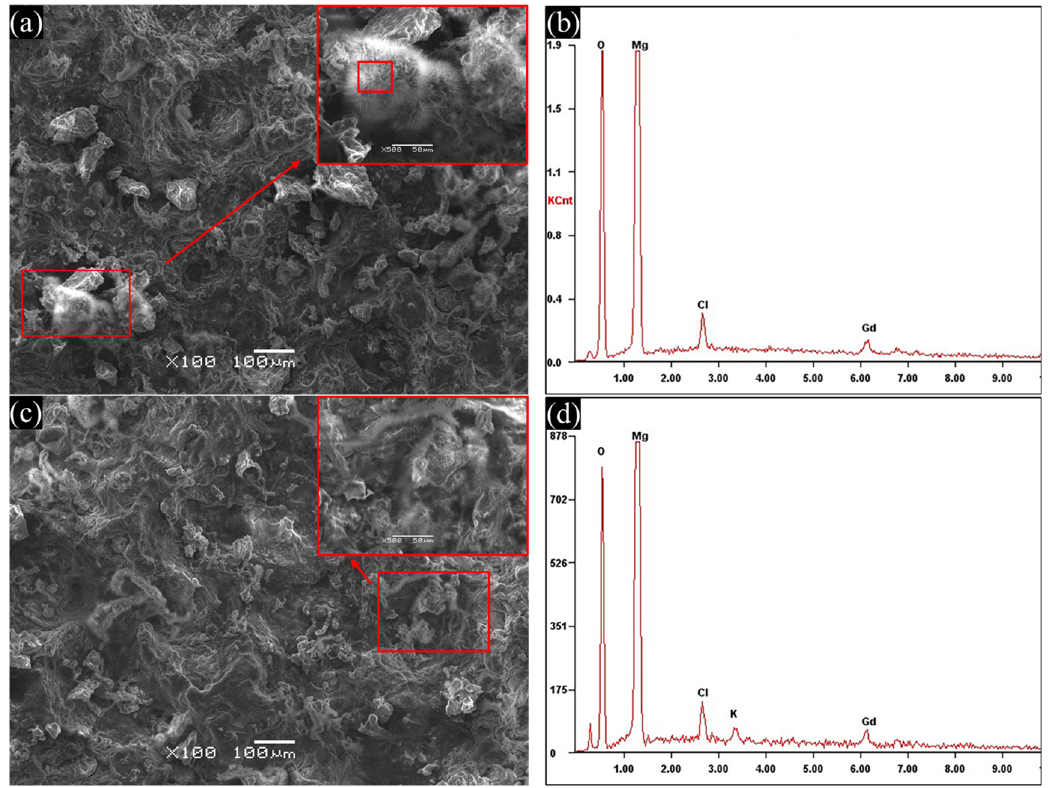
Figure 6. Surface morphologies of the as-extruded alloy ( a ) and the as-aged alloy ( c ) alloy immersed in 3 wt.% KCl for 60 min and selected area EDS spectra ( b , d ).